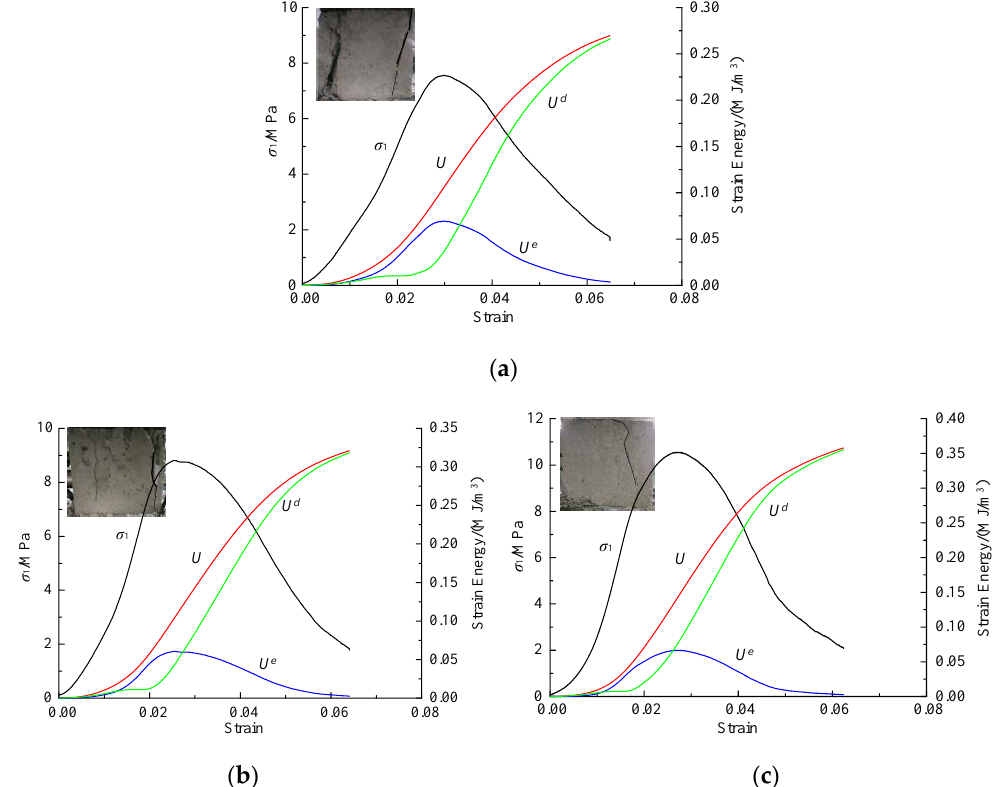
Figure 5. Stress and energy with strain for cement mortar samples: ( a ) A-0.1 – 1; ( b ) A-0.5 – 2; ( c ) A-1.0 – 1.